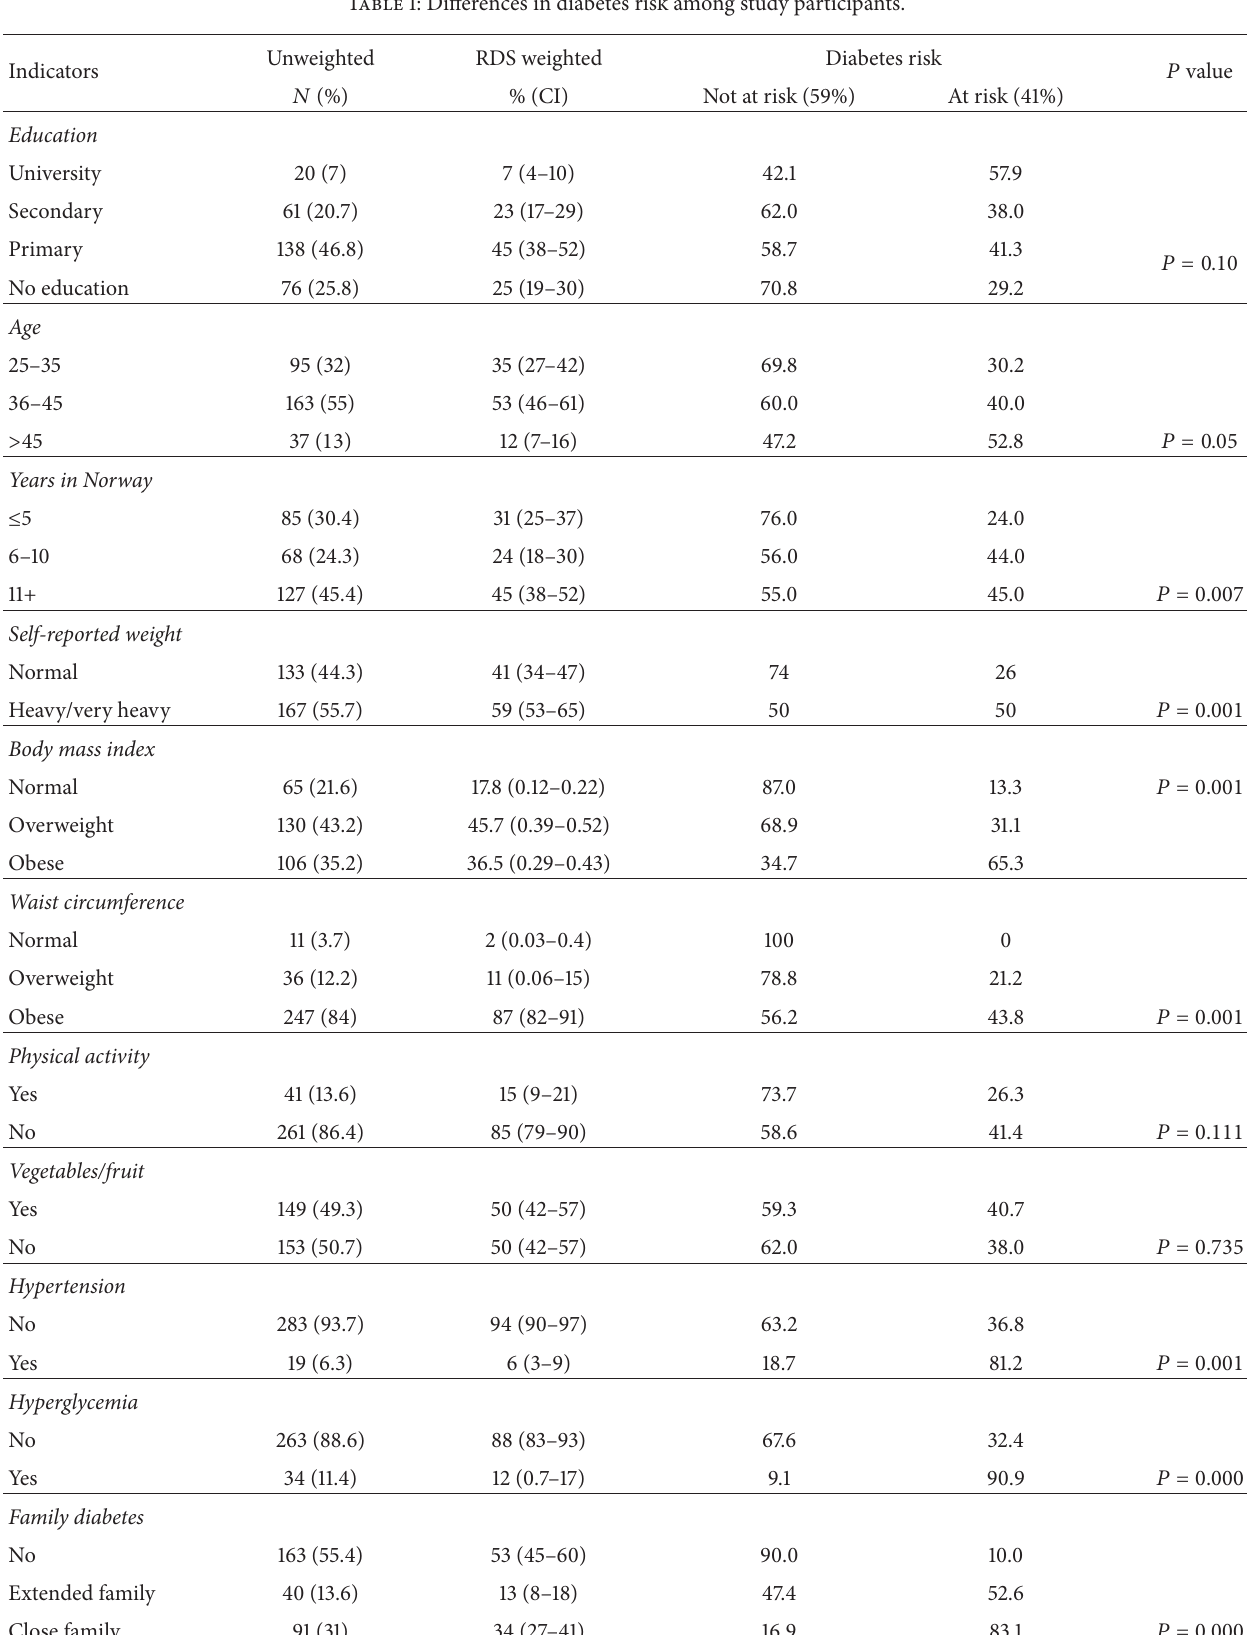
Table 1: Differences in diabetes risk among study